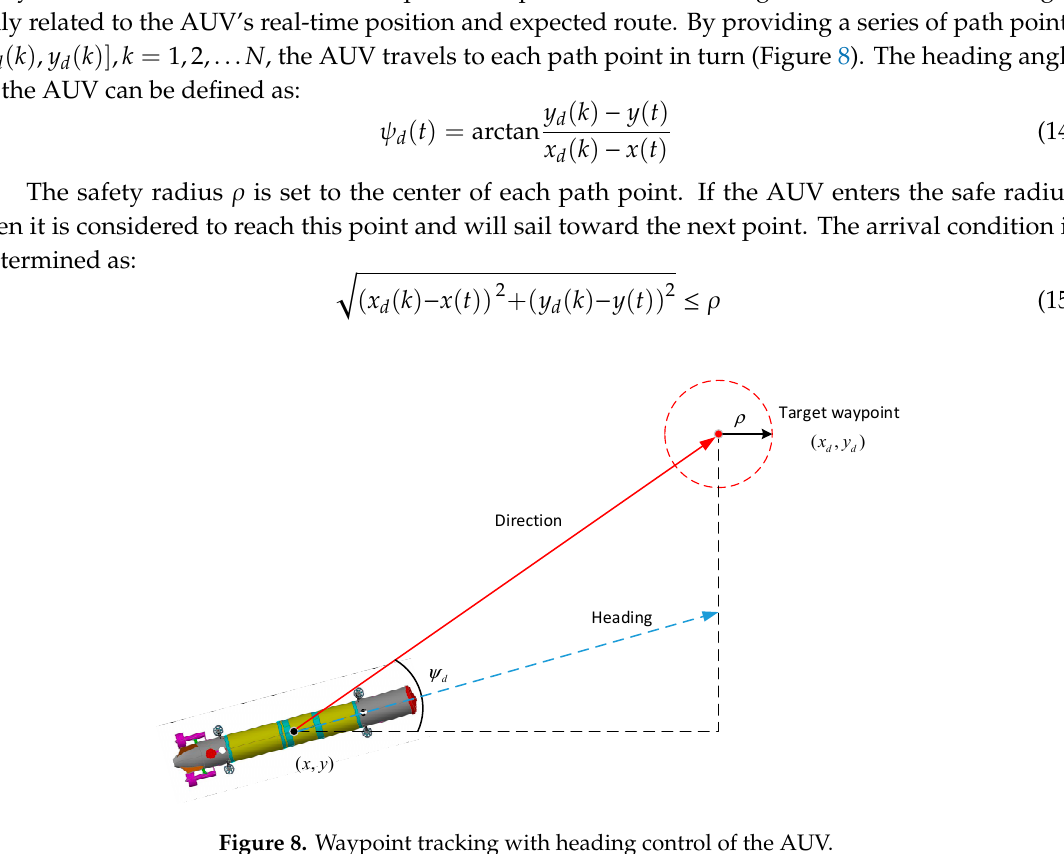
Figure 8. Waypoint tracking with heading control of the AUV.